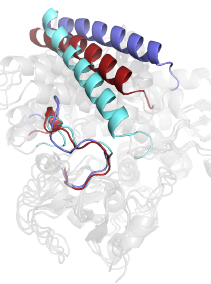
Figure 5. MD representative structures of the open form in high- (red and grey) and low- (blue and grey) ionic strength condition (in NaCl buffer) aligned over the crystallographic structure of the closed form of P450 OleP (cyan and